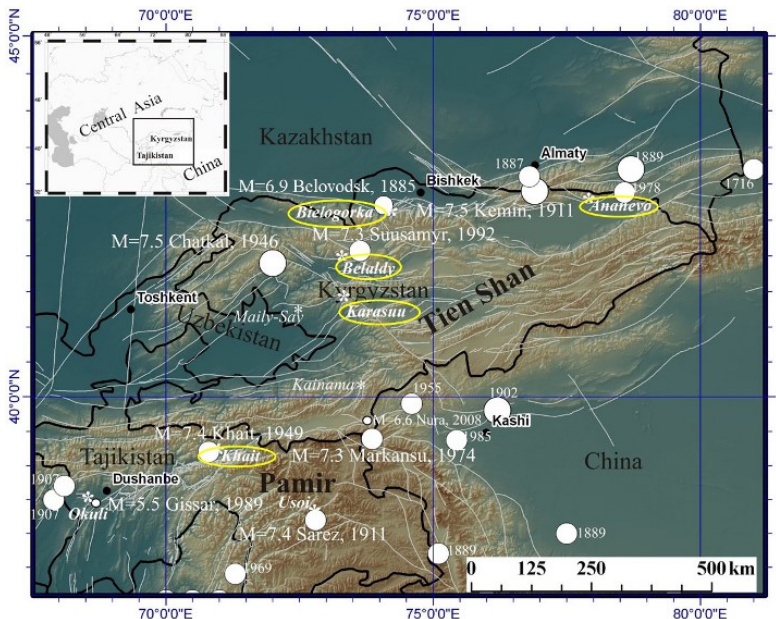
Figure 4. Maps of rockslide locations in the Tien Shan, including examples of proved earthquake-triggered failures: the 1911 Ananevo and 1992 Belaldy rockslides, the 1949 Khait rock avalanche.